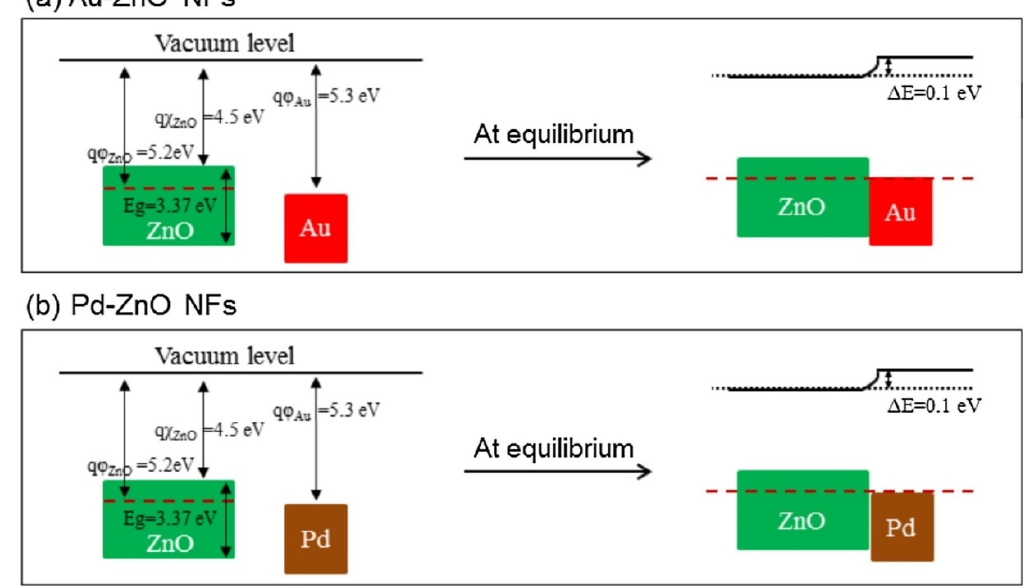
Figure 9. Energy band levelsof ( a ) Au-ZnO and ( b ) Pd-ZnO [60].